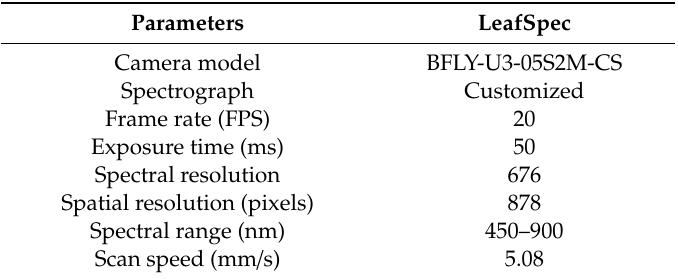
Table 1. Parameters for hyperspectral imaging